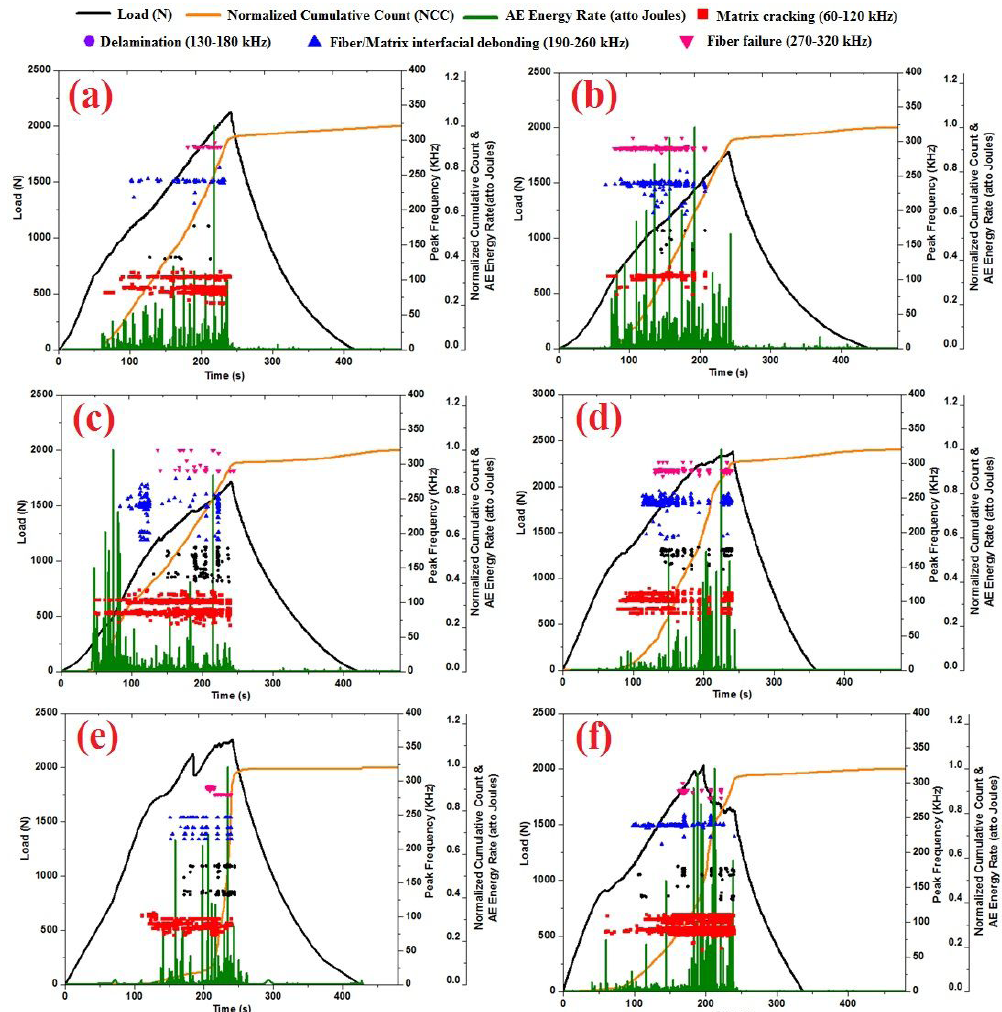
Figure 6. Representation of AE activities during indentation: (a) UD@0 o , (b) UD@10 o , (c) UD@20 o , (d) CP@0 o , (e) CP@10 o and (d) CP@20 o